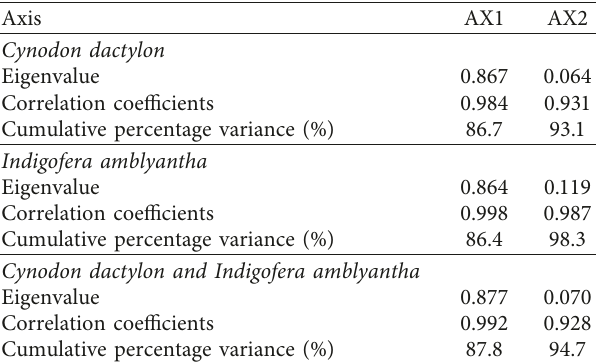
Table 4: Cumulative percentage variance, eigenvalue, and corre- lation coefficients for the first two axes of the